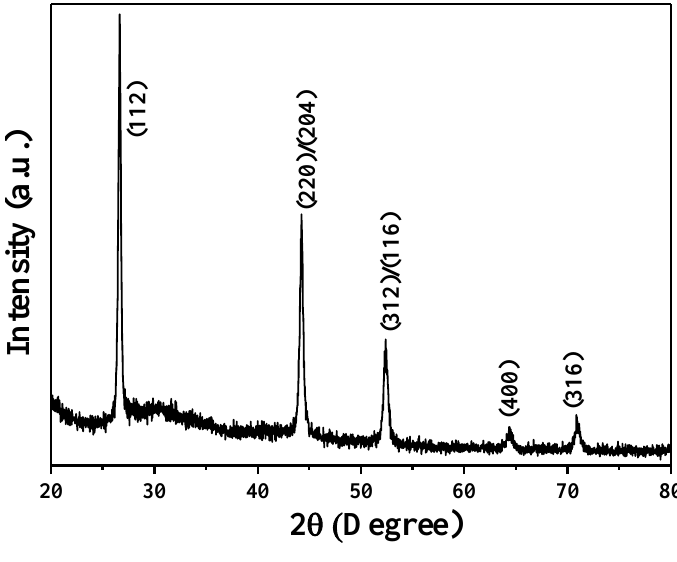
Figure 1. X-ray pattern of the synthesized CIS